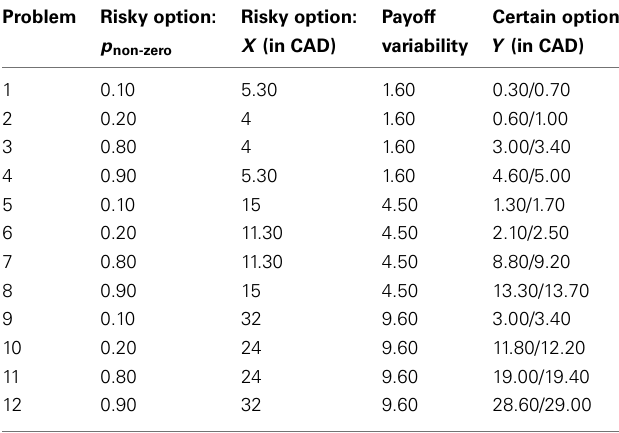
Table 2 |Twelve choice problems (Hau et al., 2010).